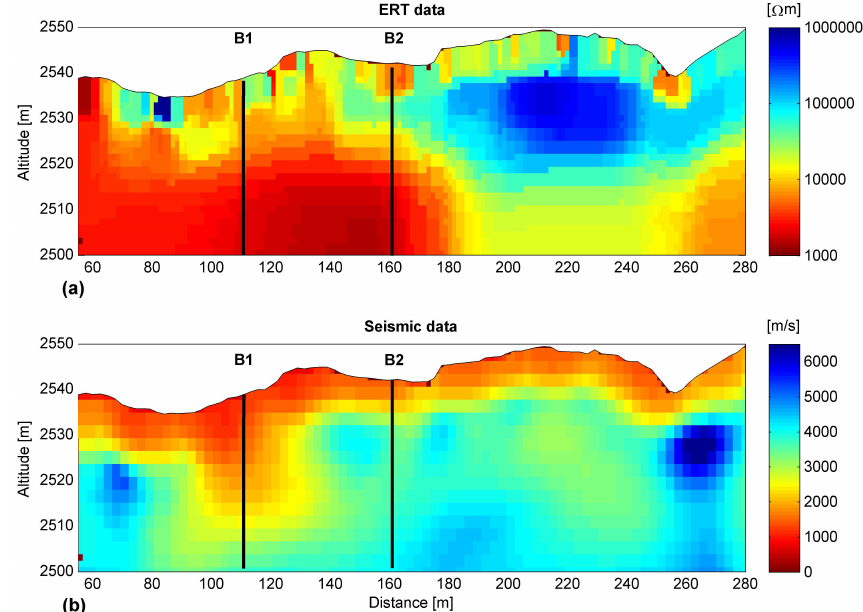
Fig. 6. Geophysical inversion results for Muragl rock glacier. (a) ERT and (b) refraction